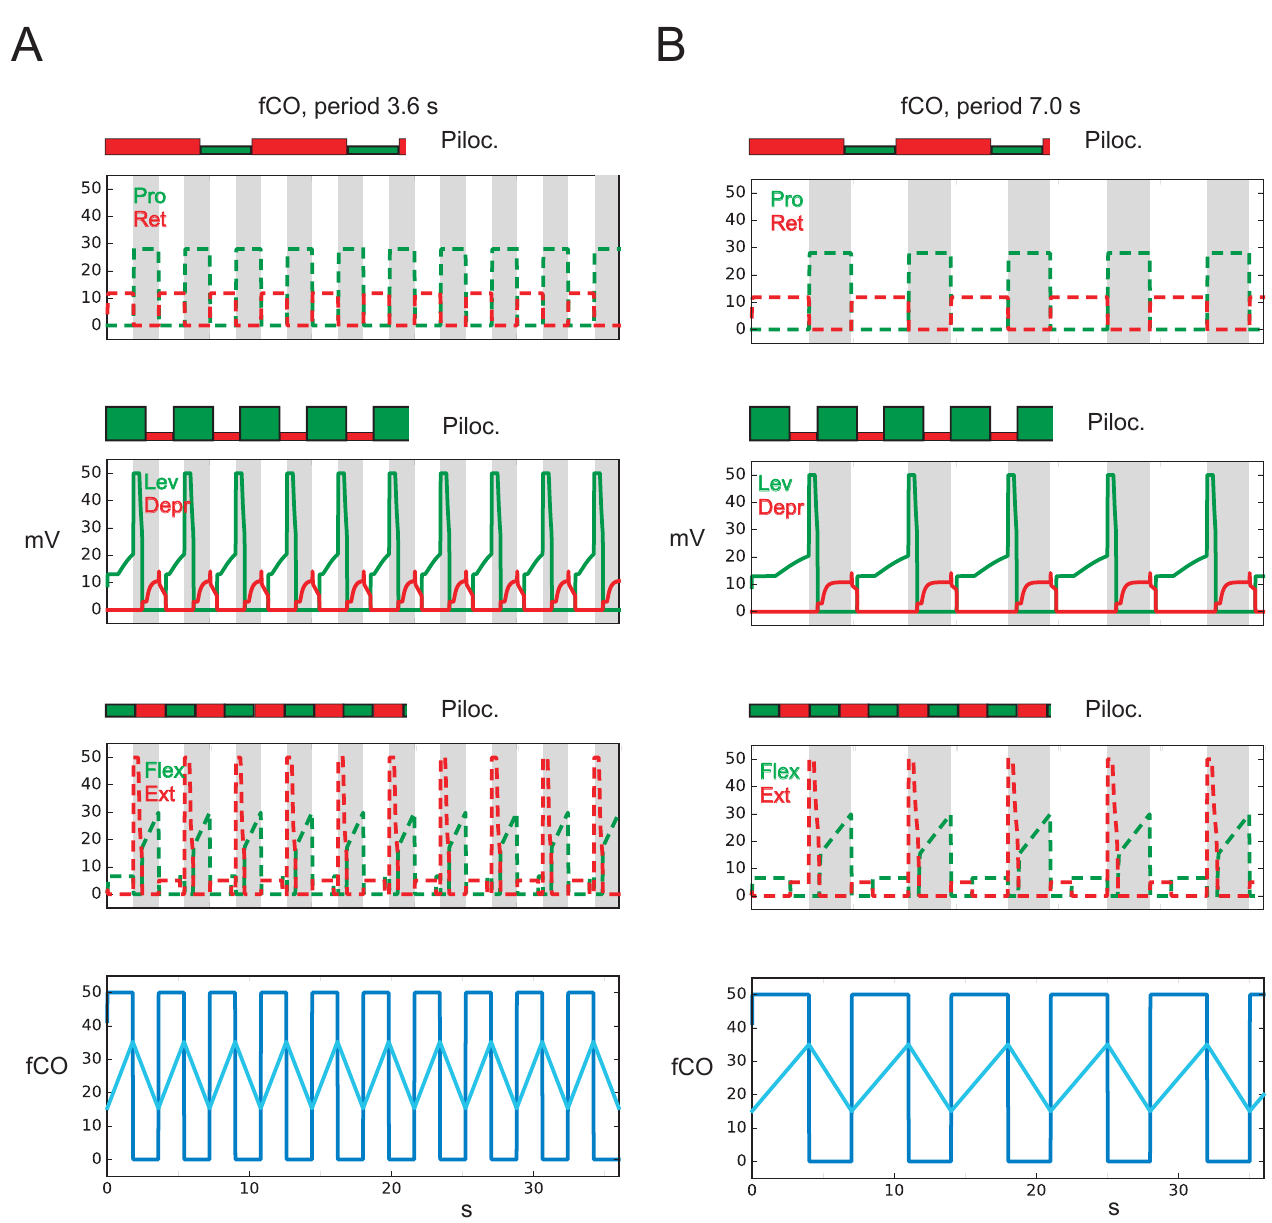
Fig 7. fCO stimulus (elongation, shown in bottom row as light blue line) drives Levator or Depressor as observed in Hess and Bu¨schges (1999). Cycles driven by pilocarpine only are plotted for each joint on top of the fCO-driven results (same scale). The former are marked by the same colors but with filled rectangles. A) Sensory input, period: 3.6 s, B) Sensory input, period: 7.0 s. Abscissa: time (s), ordinate (mV). Dashed lines: simulation data for which no biological results are given. Gamma flexion corresponds to fCO apodeme elongation, fCOpos: position input to Levator-Depressor joint (gamma joint), light blue line indicates fCO apodeme position, fCO: (velocity) input to unit swing or unit stance (dark blue